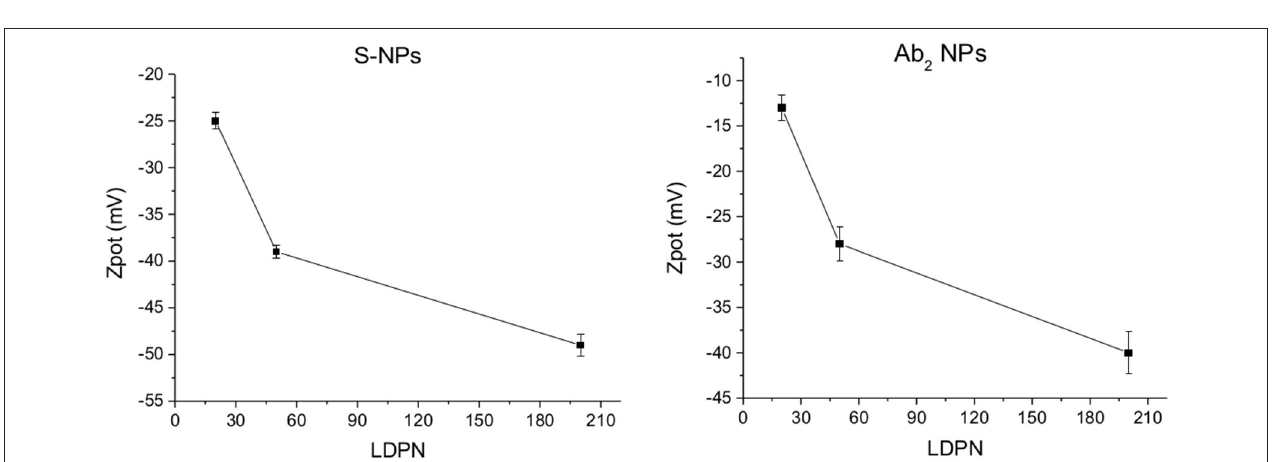
FIGURE 3 | ζ -potential of Ab 2 -NPs (left) and S-NPs (right) as a function of LDPN. Measurements performed at pH 8 using a ZetaPals